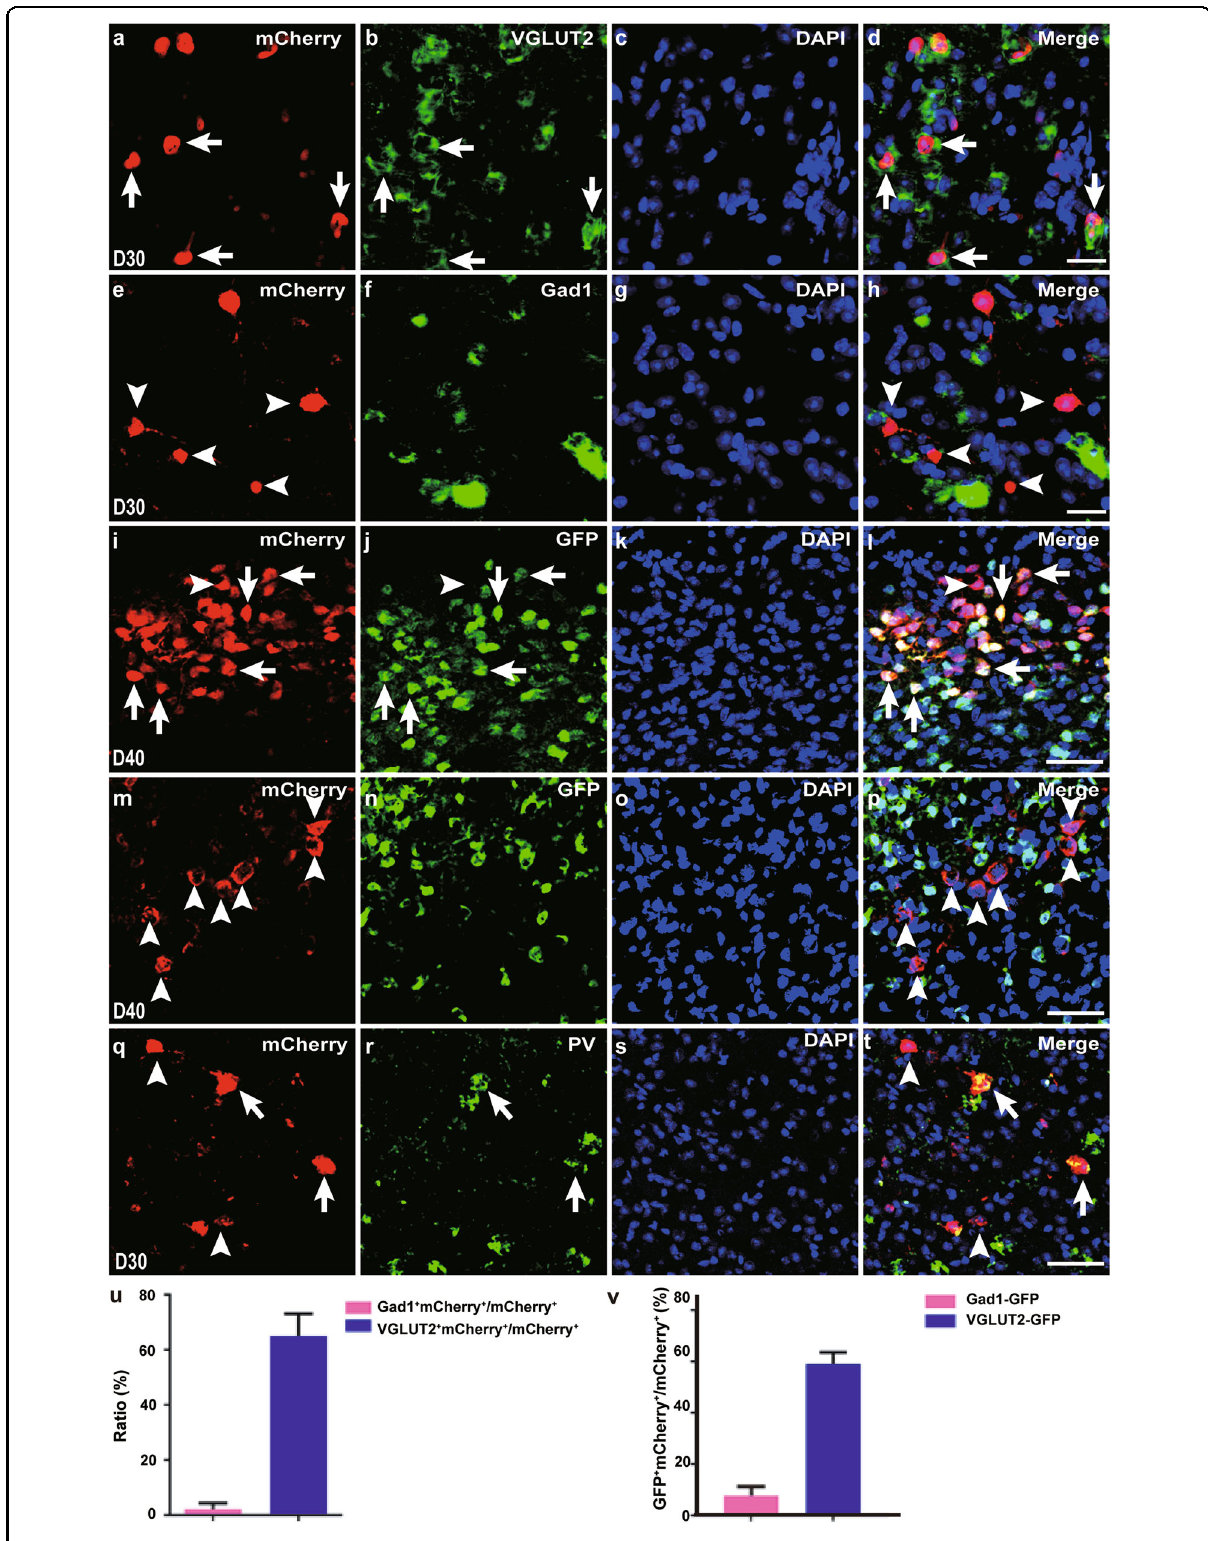
Fig. 3 (See legend on next